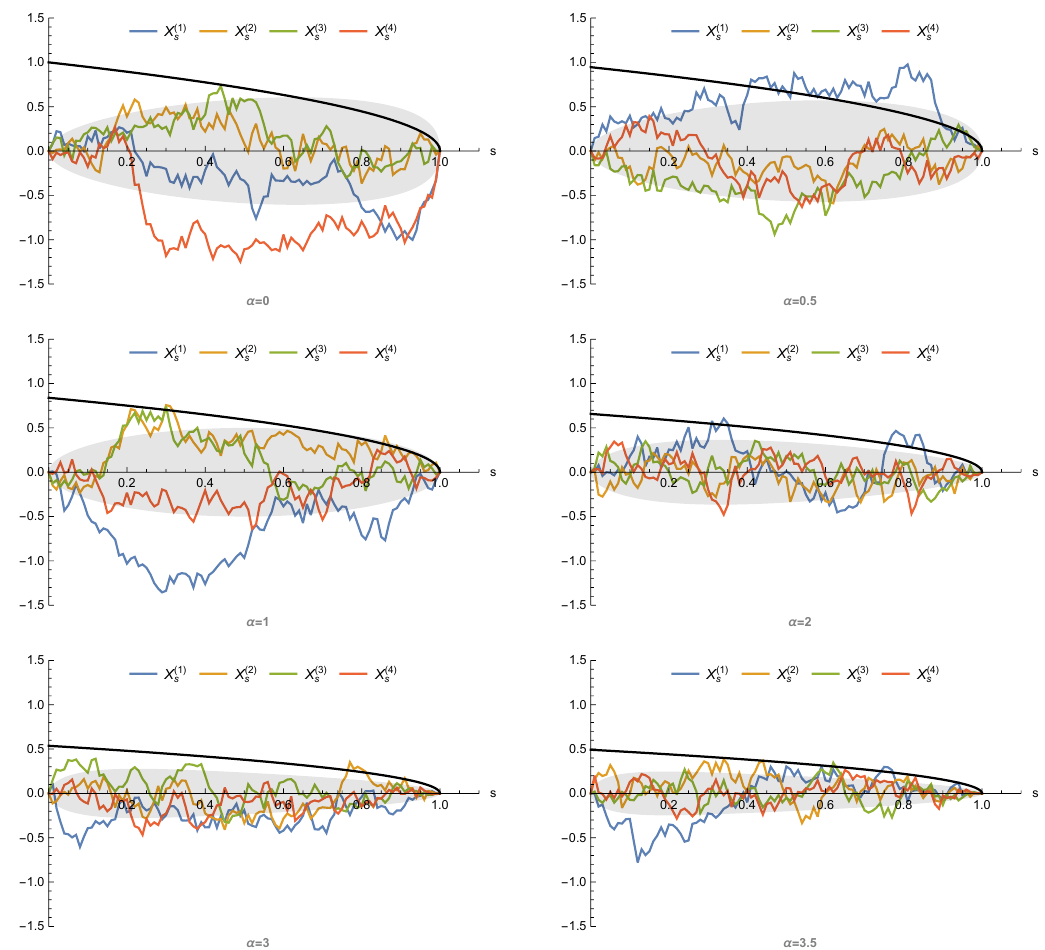
Figure 3. Four simulations of X s , s ∈ [ 0,1 ] , as defined in (26) with t = 0, x = 0, for six different values of α . The light grey areas represent one standard deviation of X s above and below its expected value (null in the simulations). The black solid curves represent the optimal stopping